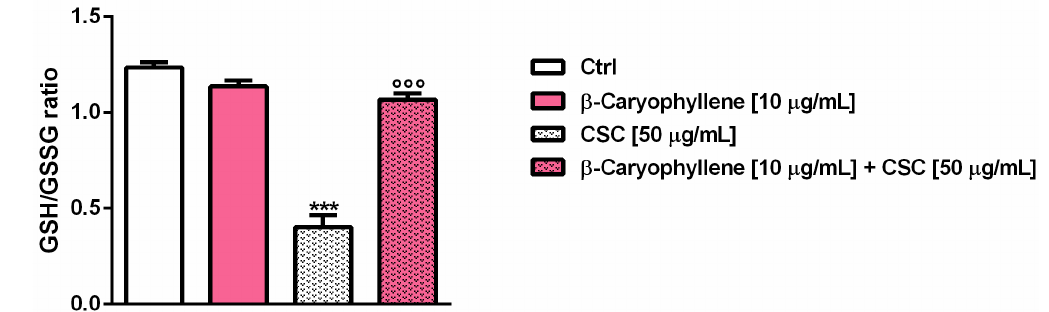
Figure 7. Intracellular ROS levels induced by β -caryophyllene and cigarette smoke condensate (CSC) in MDA-MB-468 cancer cells after 24 h exposure. ( A ) Representative images of cells stained by DCF. Original magnification 10×. ( B ) Bar graph of DCF-fluorescence. Data are displayed as mean ± SE of at least three independent experiments with at least three technical replicates ( n = 9). *** p < 0.001, significant lowering of cell viability with respect to the control (ANOVA + Dunnett’s multiple comparison post-hoc test). °°° p < 0.001, significant difference with respect to CSC (Student’s t- test). Scale bars = 20 μm.